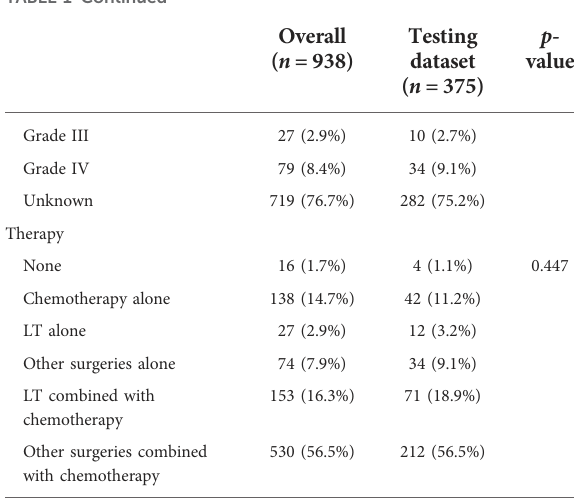
TABLE 1 Comparison of demographic and clinical characteristics between the overall and testing datasets.